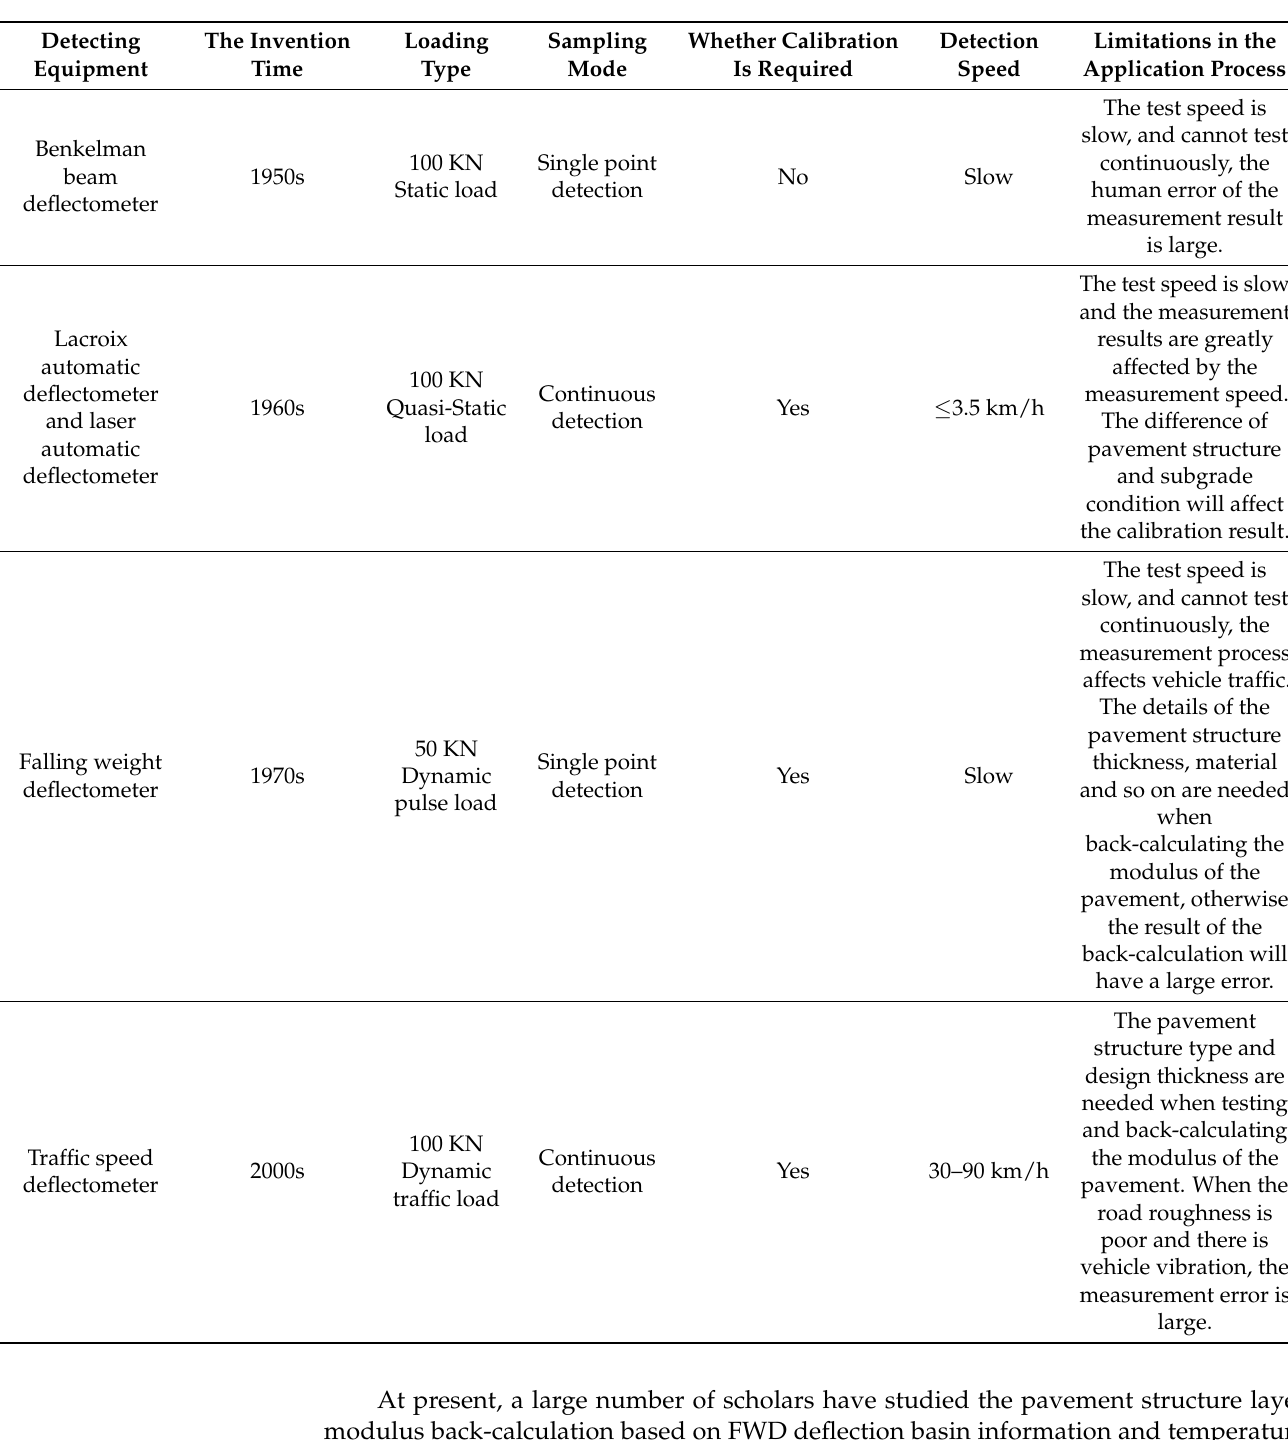
Table 1. Comparison of common pavement bearing capacity testing